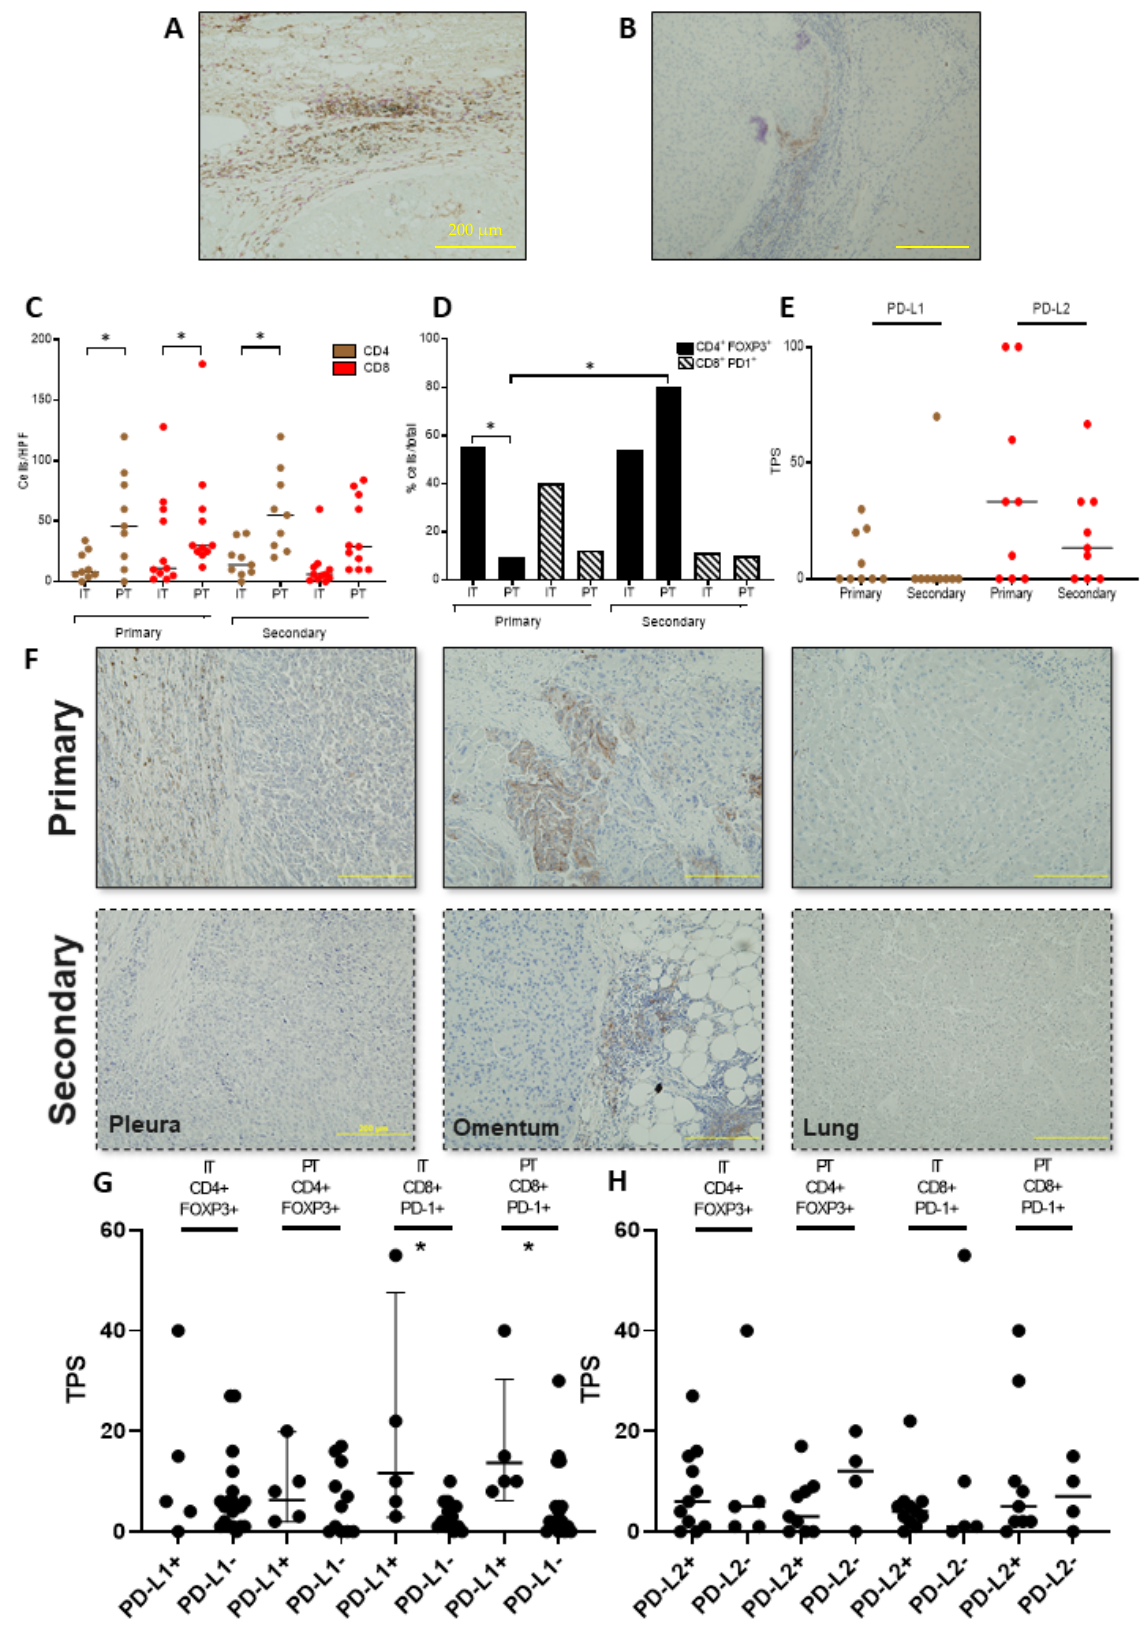
Figure 1. Immunohistochemical characterisation of the immune cell infiltrate in primary and secondary HCC. Representative sections illustrating the characteristics of the T-cell infiltrate in a primary HCC sample. A red “T” highlights the